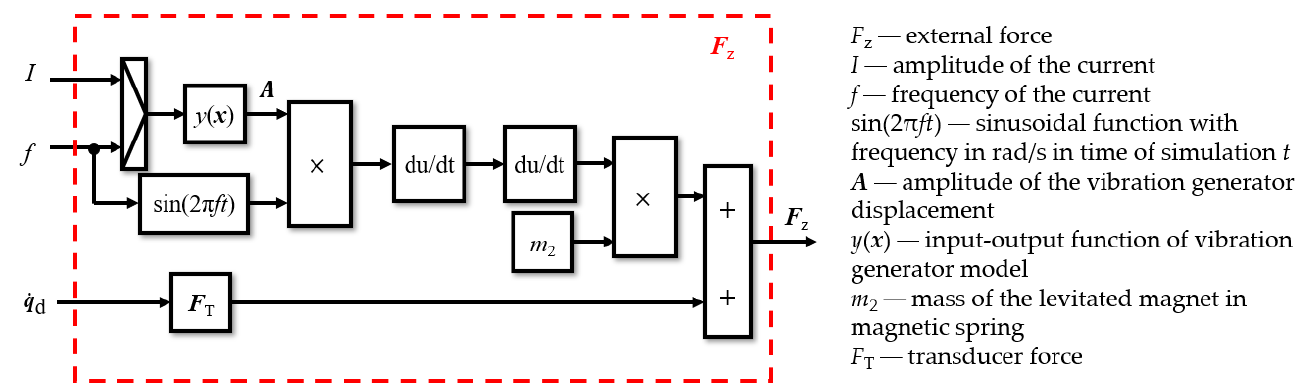
Figure 8. Block diagram by Simulink/Matlab of the vibration generator simulation model based on the neural network model.